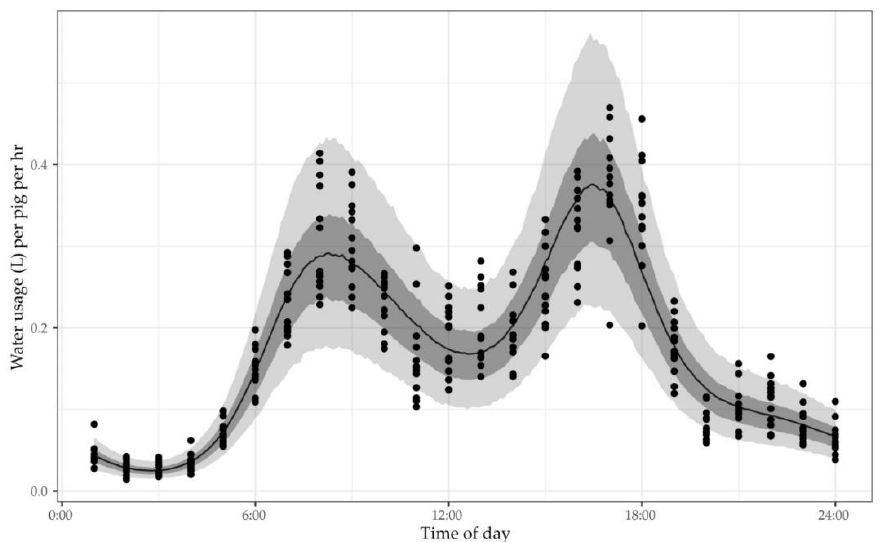
Figure 2. Water usage per pig as a function of time of day over 13 consecutive days (27 August